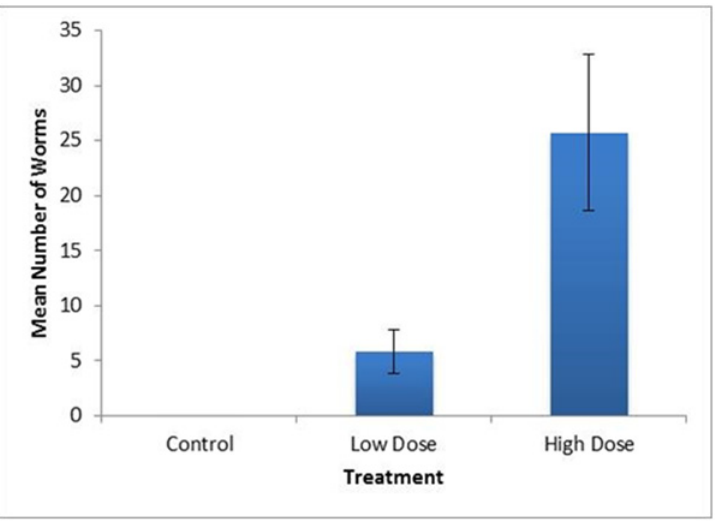
Fig 2. Mean number of adult worms isolated from heart and lungs. The mean number of adult worms isolated from the heart and lungs of HD rats was significantly higher ( p = 0.001, F = 10.11, DF = 2) than that isolated from LD or control groups. Worm numbers ranged from 0 – 16 in the LD group and 8 – 57 in the HD group. Mean worm numbers of control rats was 0, of LD rats was 5.9, and of HD rats was 26. Standard error bars are